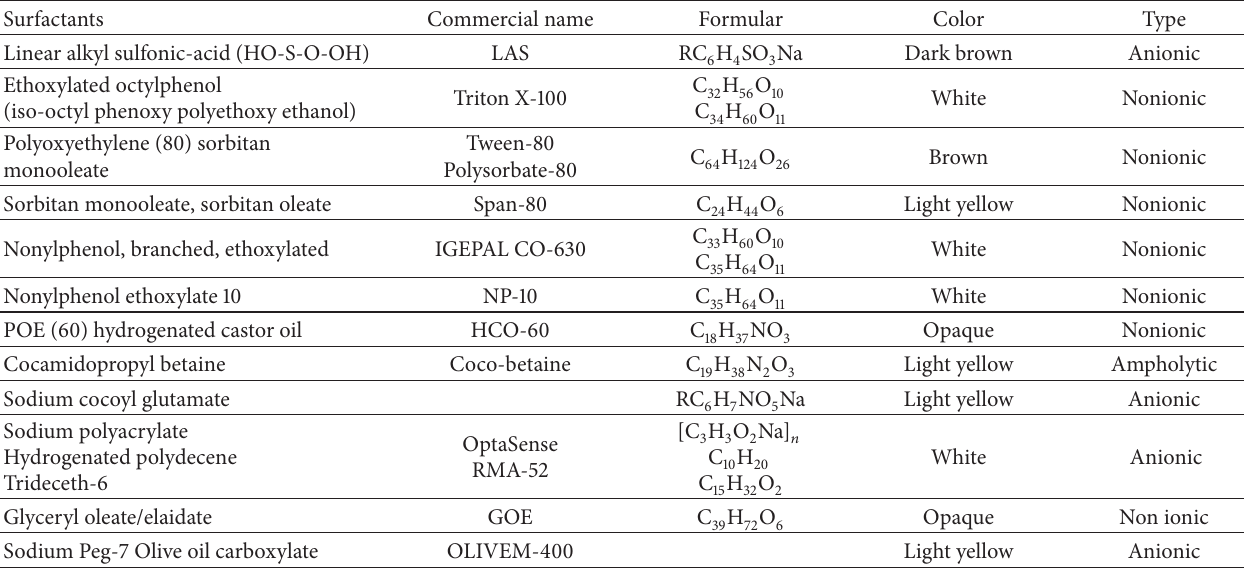
Table 1: Several surfactants used for synthesizing a LS using water.